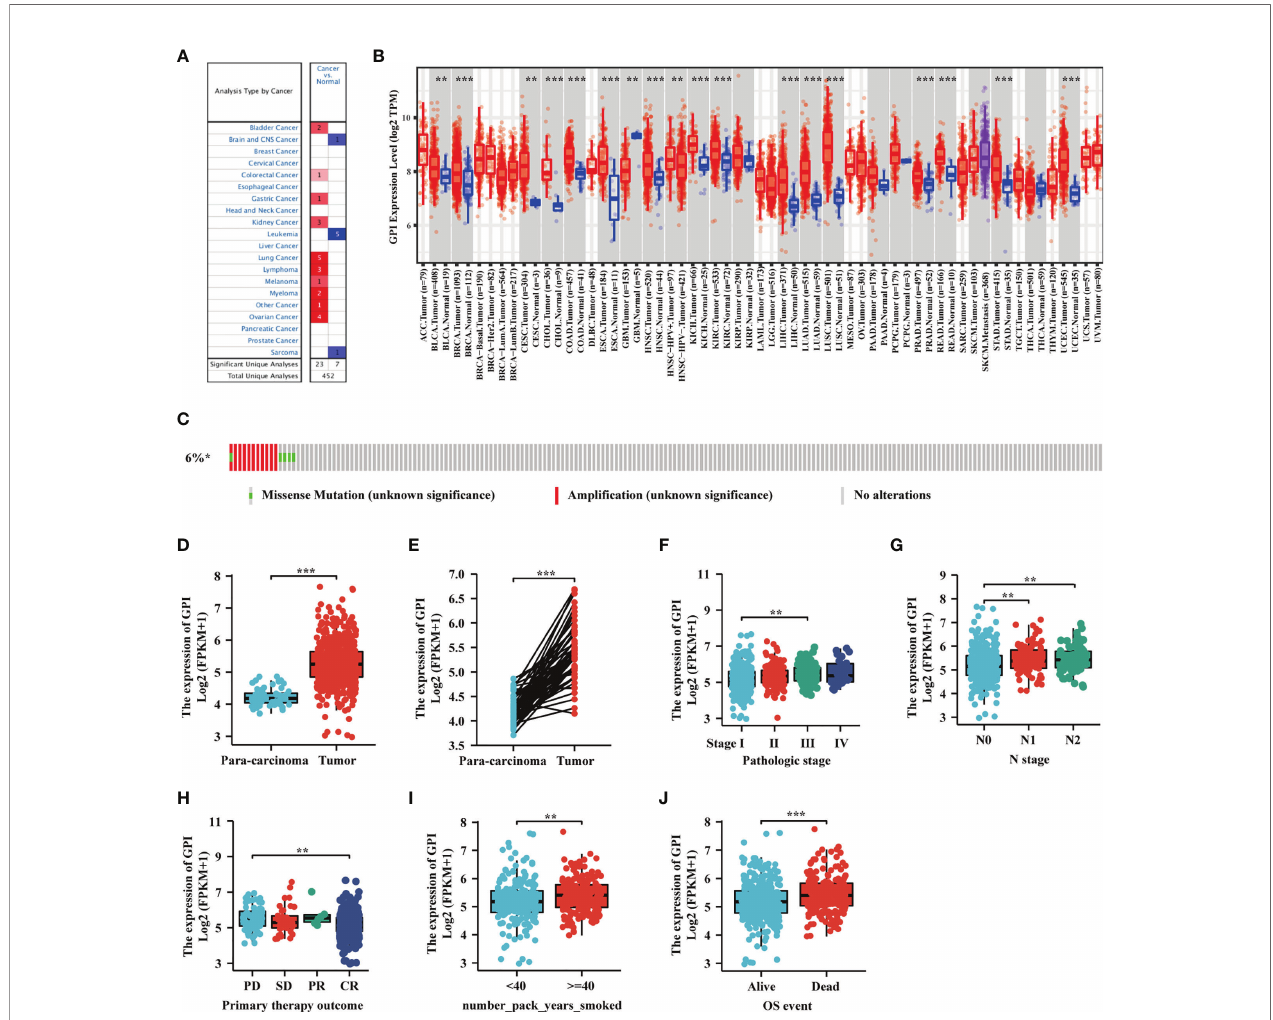
FIGURE 2 | The expression level of glucose-6-phosphate isomerase (GPI) in different human cancers. (A) Increased or decreased GPI expression in datasets of different cancers compared with normal tissues in the Oncomine database. (B) TIMER was used to detect the expression levels of GPI in different tumors in The Cancer Genome Atlas (TCGA) database. (C) The cBioPortal OncoPrint map shows the distribution of GPI genome changes in lung adenocarcinoma (LUAD) patients. (D – J) Expression level of GPI in normal tissues and paired adjacent tissues [unmatched tissues (D) and matched tissues (E) ] and the tumor tissues from patients with different clinical characteristics in TCGA [clinical stage (F) , N stage (G) , primary therapy outcome (H) , smoking pack-years (I) , and OS event (J) ]. **p < 0.01, ***p <